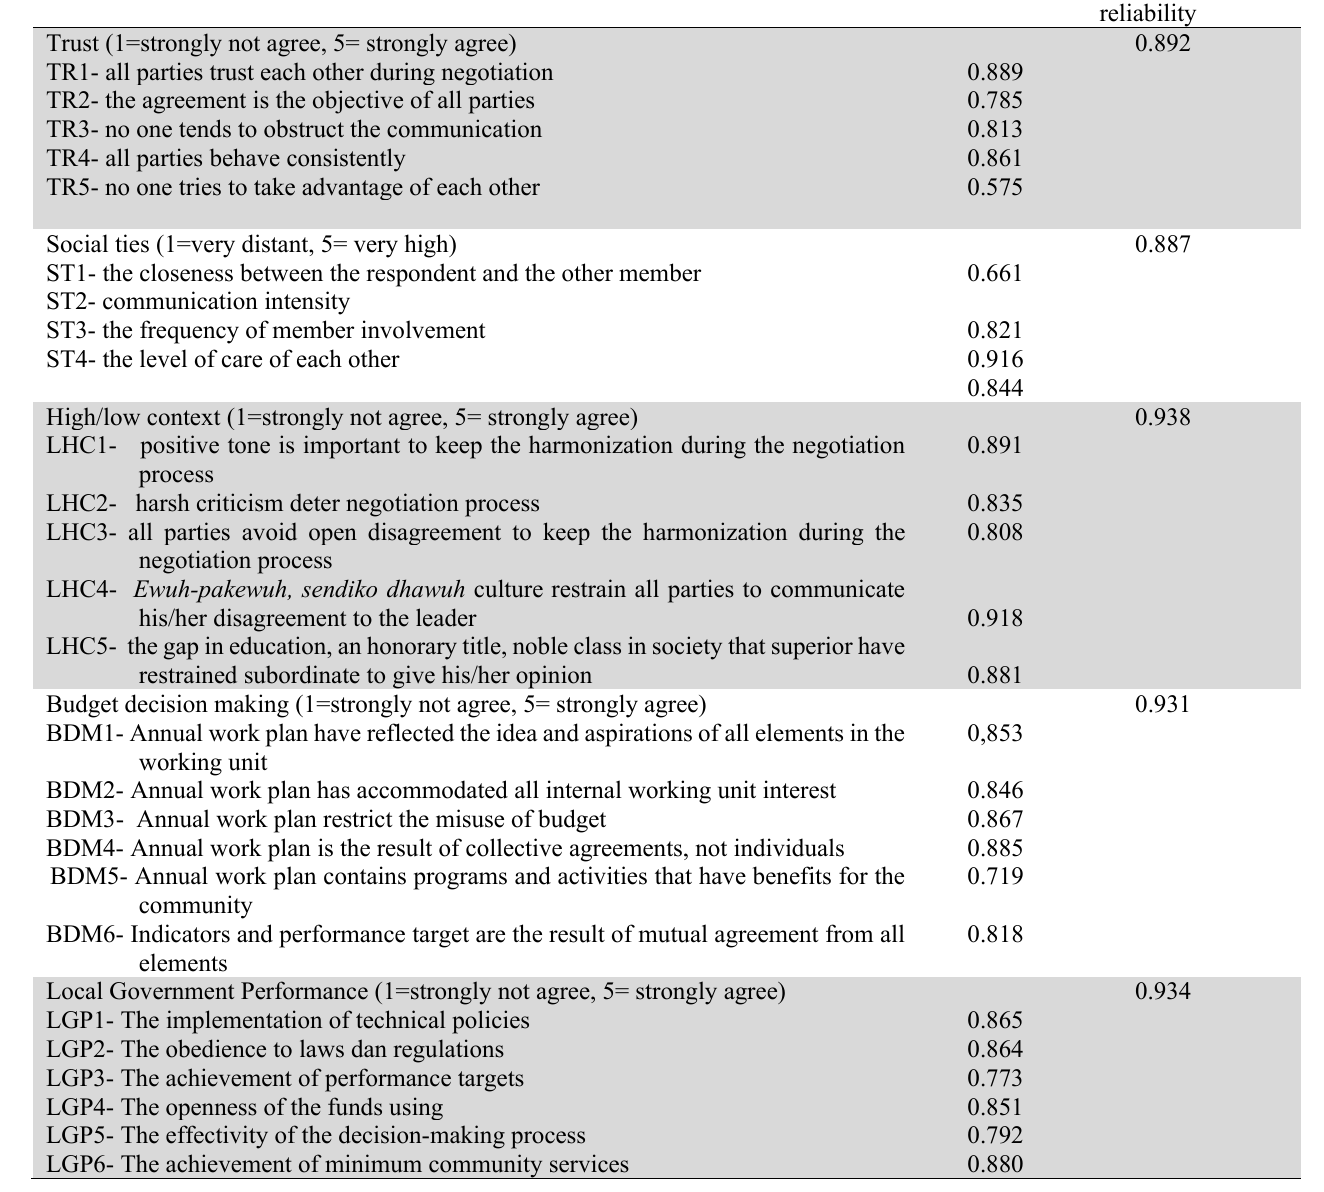
Measurement model Variable Outer loading Composite